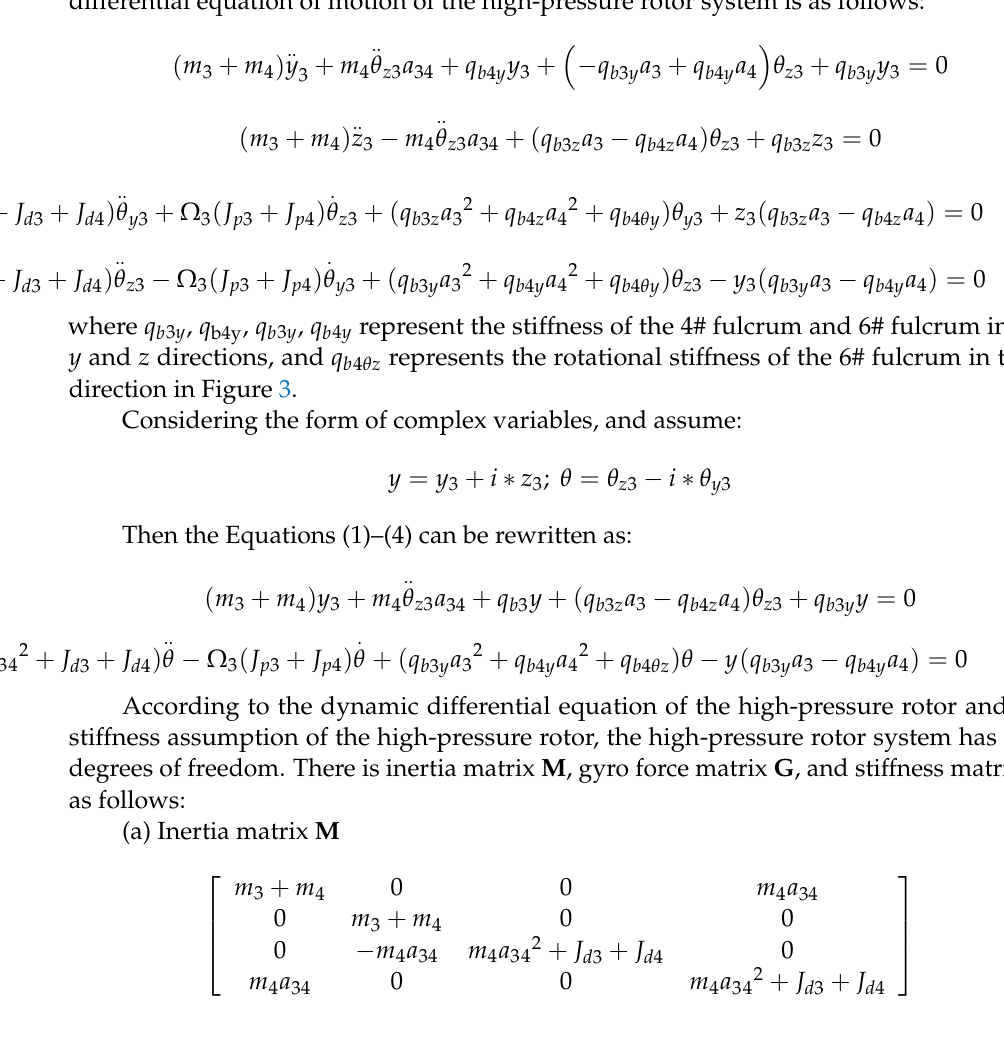
Figure 3. Equivalent dynamic model of the high-pressure rotor system. The equivalent disk D 3 of the high-pressure compressor has the vibration of y 3 (ver- tical) and z 3 (horizontal), and the rotation angles are θ y 3 and θ z 3 , respectively. The vibra- tions corresponding to the equivalent disk D 4 are y 4 (vertical), z 4 (horizontal), θ y 4 , θ x 4 . The differential equation of motion of the high-pressure rotor system is as follows: